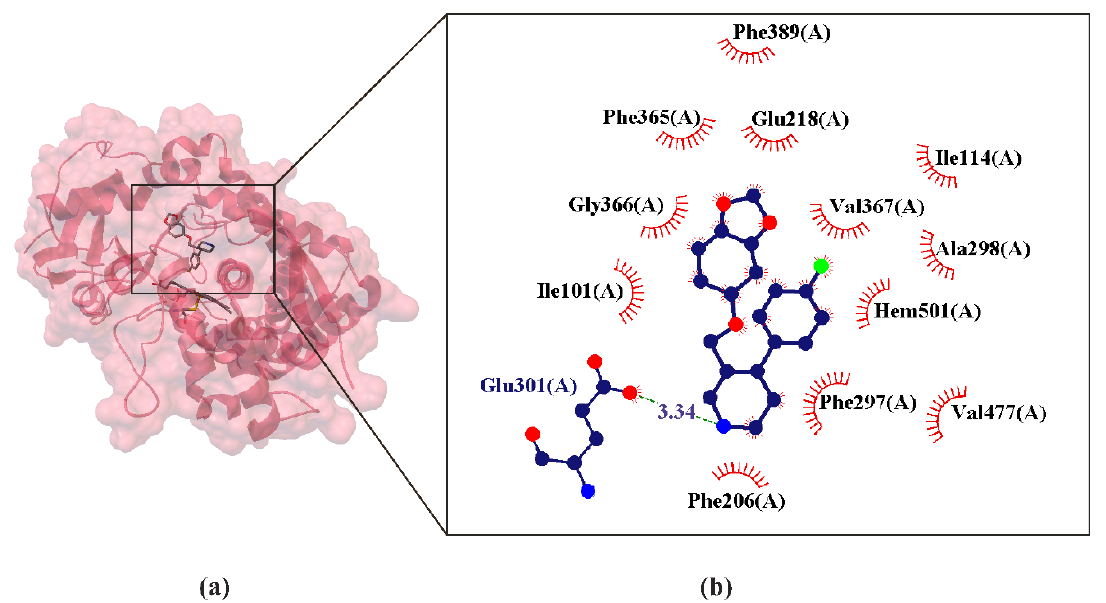
Figure 2. X-ray structure of paroxetine (8PR505) bind in the active site cavity of the CYP2B4 crystal ( a ), with the enlarged area showing the structural elements around the ligand-biding site (PDB ID: 4JLT, 2.14 Å) [55]. Residues that form hydrogen bonds (dashed lines) with paroxetine are shown in ball-and-stick representation with the interatomic distances shown in Å. Residues forming Van der Waals interactions with paroxetine are shown as labeled arcs with radial spokes that point toward the ligand atoms ( b ).